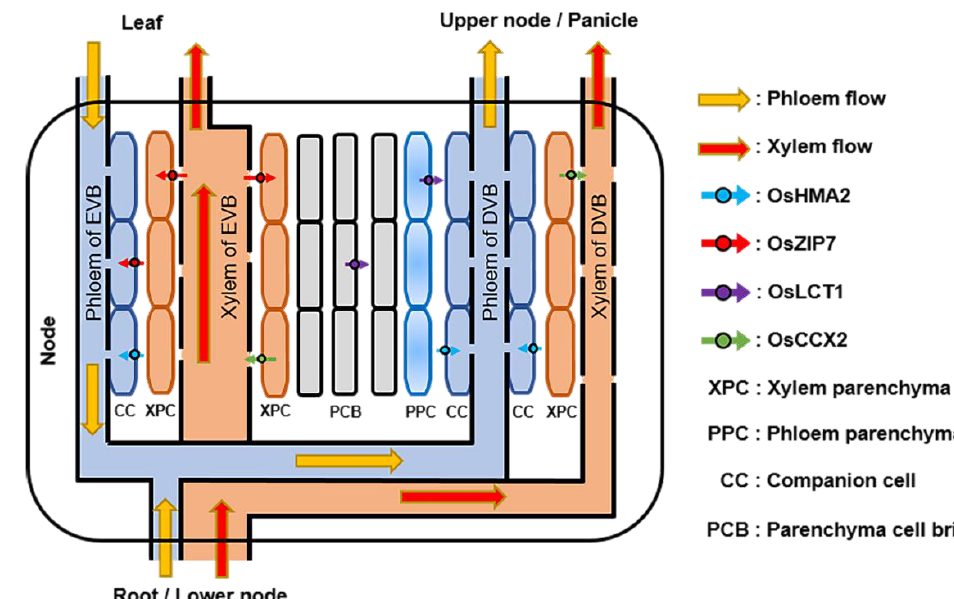
Figure 2. Schematic diagram of Cd transport in rice nodes. OsHMA2, localized in the phloem parenchyma and companion cells of both enlarged and diffuse vascular bundles in stem nodes, mediates the loading of Cd into the phloem for the preferential distribution to the upper nodes and panicle. OsZIP7, localized in both xylem and phloem parenchyma cells of the enlarged vascular bundles, can transport the Cd from xylem to phloem and unload Cd from xylem to parenchyma cell bridge. OsLCT1, localized in parenchyma cell bridge and phloem parenchyma cells of diffuse vascular bundles, mediates the intervascular transfer of Cd and promotes the transport of Cd to the grain through phloem. OsCCX2, localized in the xylem parenchyma cells of enlarged and diffuse vascular bundles, mediates the loading of Cd into the xylem and promotes Cd transport into grains.